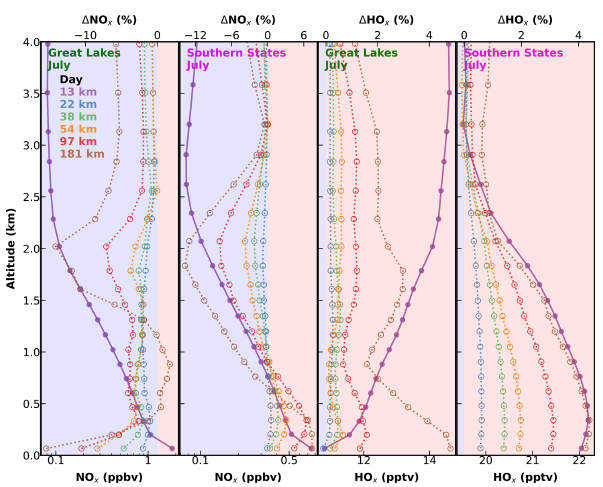
Figure 4. Change in afternoon NO x vertical distribution in the lower troposphere at different resolutions in July. The absolute monthly and regional mean mixing ratios (lower x axis) of NO x and HO x are shown as filled symbols and solid lines at 13km res- olution, respectively, and the differences vs. 13km resolution (up- per x axis) are shown as empty symbols and dashed lines for the other resolutions, respectively (see legend in the left column). The positive (light red) and negative (light blue) difference regimes are color-divided.